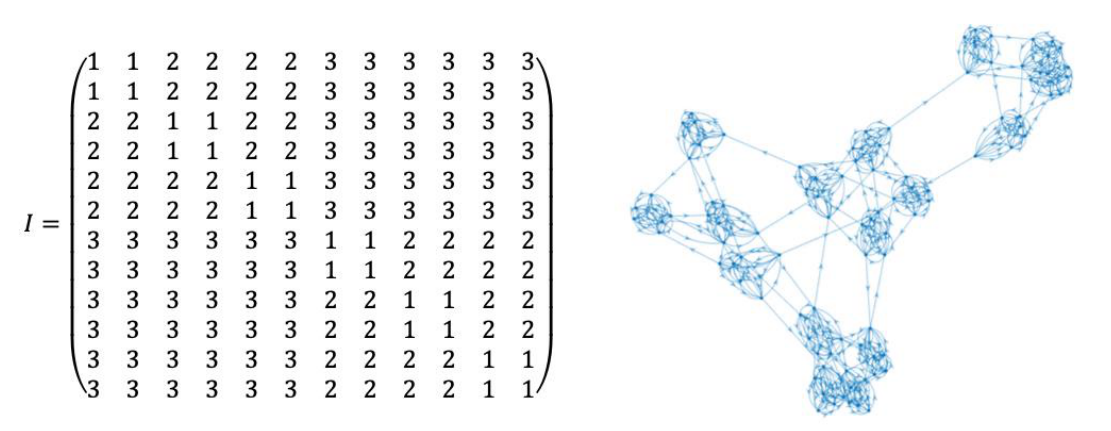
Figure 12. (left) Index of a hierarchical network with three-community sizes 𝐿 = {2,3,2} . (right) A realization of a network with 𝐿 = { 6,4,4 } and connection probability 𝑝 = {1,0.04,0.002}